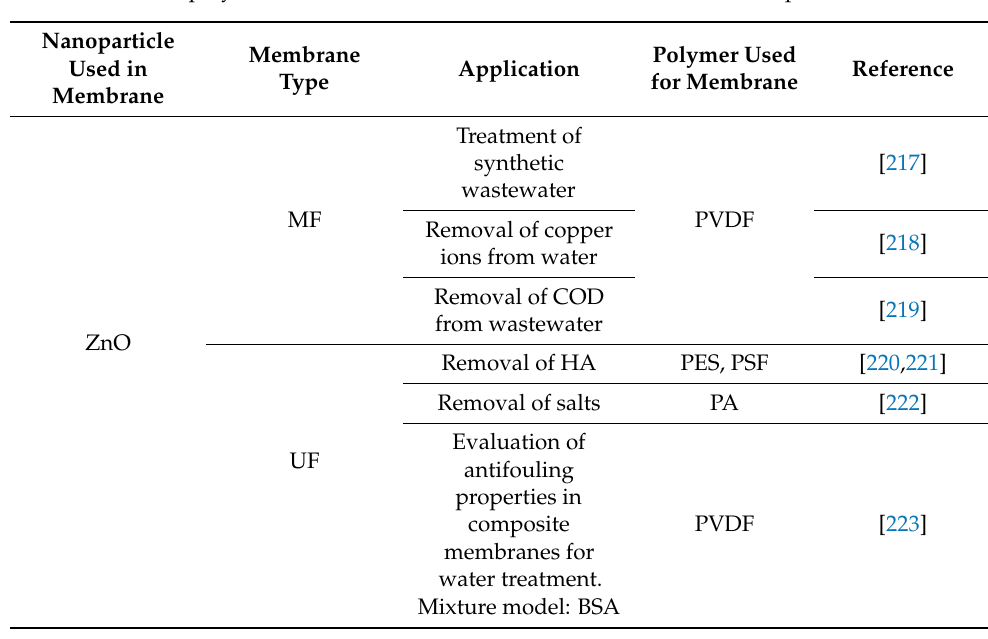
Figure 17. Schematic representation of the fabrication of a polymeric nanocomposite membrane, along with its surface properties [Reprinted with permission from ref. [87], Kausar, A.; Bocchetta, P. Polymer/Graphene Nanocomposite Membranes: Status and Emerging Prospects. J. Compos. Sci. 2022 , 6 , 76. https://doi.org/10.3390/jcs6030076, Copyright © MDPI]. Table 7. Different polymeric membranes decorated with metal oxide